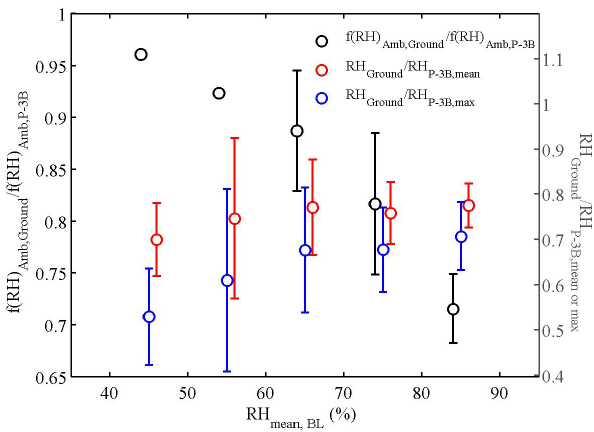
Fig. 11. Ratio of the f (RH) amb,ground to f (RH) amb,P-3B (black dots), of the averaged and maximum values as a function of the av- eraged relative humidity measured during the P-3B profiles within the